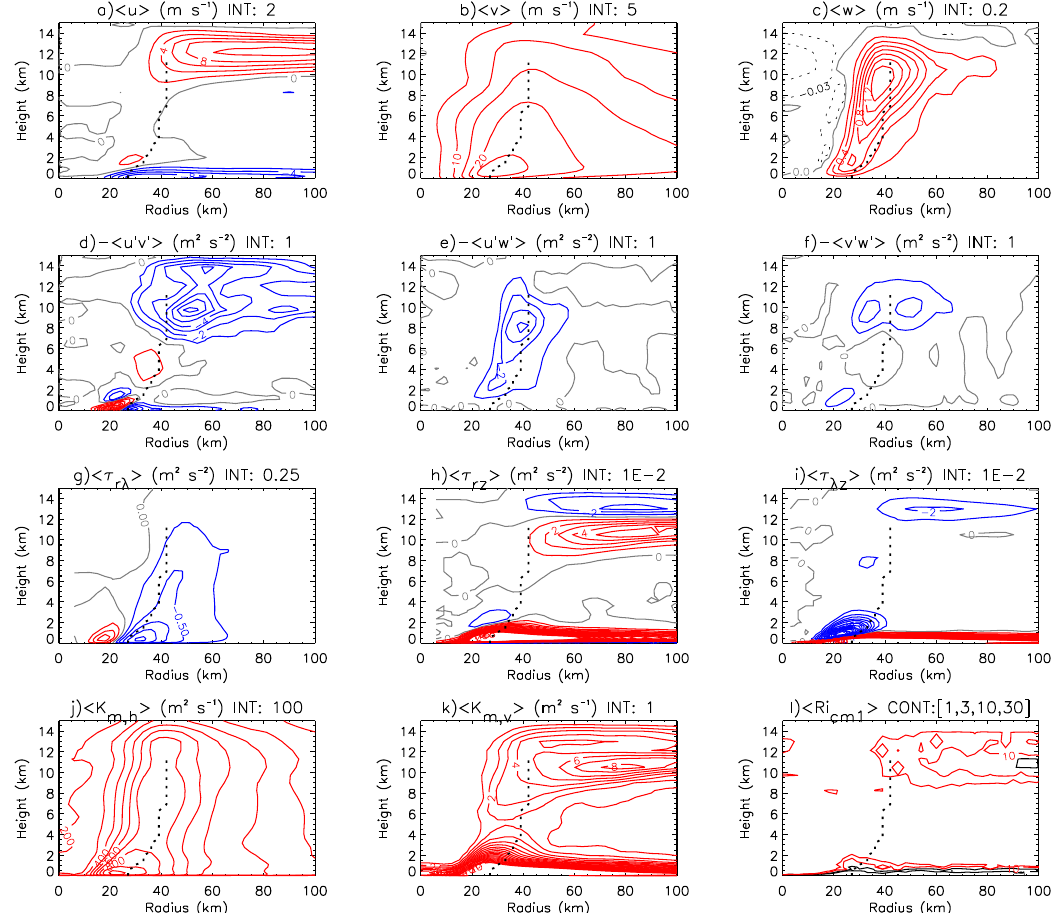
Fig. 14. Radius-height contour plots of resolved and subgrid-scale eddy momentum fluxes and related quantities from the 3D3k simulation using data at a 2-minute interval and averaged over the first intensification interval (65 - 69 h), which is the interval of maximum intensification rate. Except where otherwise noted, there are 20 positive red contours and 20 negative blue contours. Panel (a): h u i with contour interval 2 m s − 1 ; panel (b): h v i with contour interval 5 m s − 1 ; panel (c): h w i with contour interval 0.2 m s − 1 ; panel (d): resolved horizontal momentum flux h− u ′ v ′ i with contour interval 1 m 2 s − 2 ; panel (e): resolved vertical eddy flux of radial momentum h− u ′ w ′ i with contour interval 1 m 2 s − 2 ; panel (f): resolved vertical eddy flux of tangential momentum h− v ′ w ′ i with contour interval 1 m 2 s − 2 ; panel (g): subgrid momentum flux corresponding to panel (d): h τ rλ i with contour interval 0.25 m 2 s − 2 ; panel (h): subgrid momentum flux corresponding to panel (e) h τ rz i with contour interval 1 × 10 − 2 m 2 s − 2 ; panel (i): subgrid momentum flux corresponding to panel (f) h τ λz i with contour interval 1 × 10 − 2 m 2 s − 2 ; panel (j): horizontal diffusivity h K m,h i with contour interval 100 m 2 s − 1 ; panel (k): vertical diffusivity h K m,v i with contour interval 1 m 2 s − 1 ; panel (l): time and axisymmetric average of the gradient Richardson number used in the CM1 model h Ri cm 1 i with black contours 1 and 3 and red contours 10 and 30. The radius of maximum h v i at each height is shown with the black dashed curve (up to 11 km).